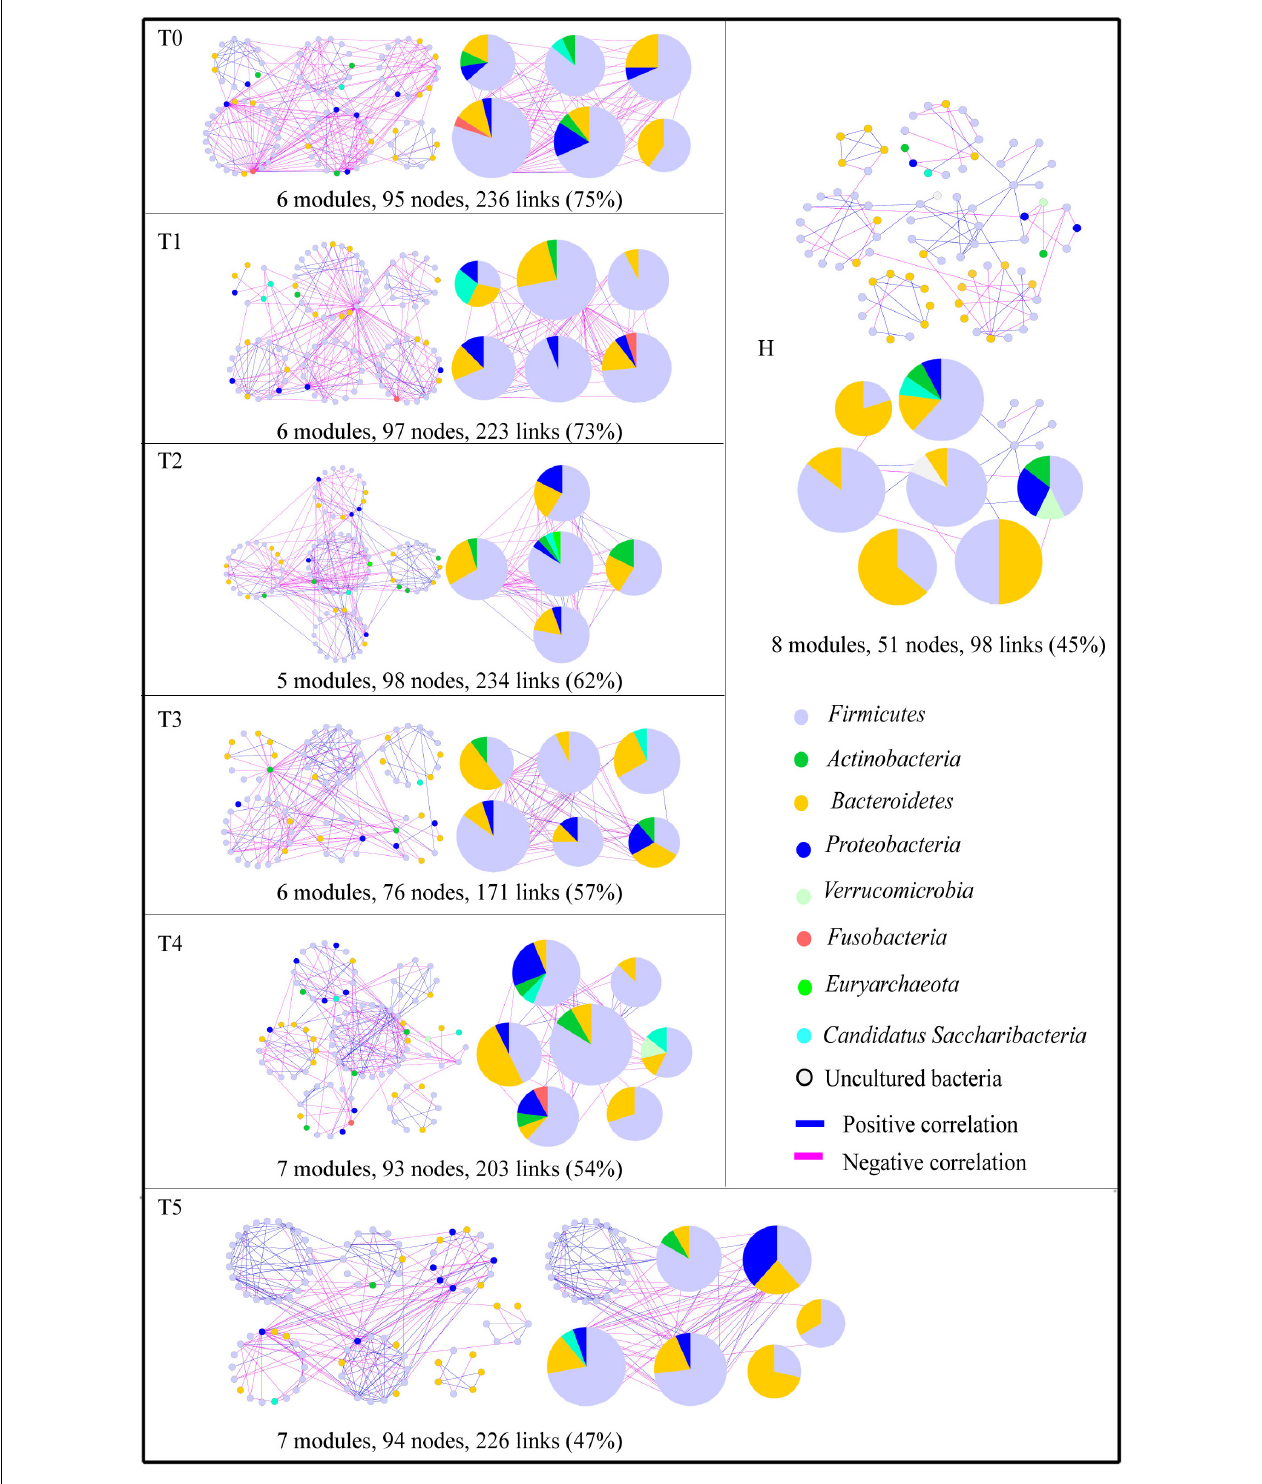
FIGURE 1 | Highly connected modules within intestinal networks of colorectal cancer patients in response to the five stages of chemotherapy. Node colors represent different major phyla; pie charts represent the composition of the modules with > 1 phyla. A blue link indicates a positive relationship between two individual nodes, whereas a pink link indicates a negative relationship. The number in bracket means the ratio of negative links accounting for the total links.